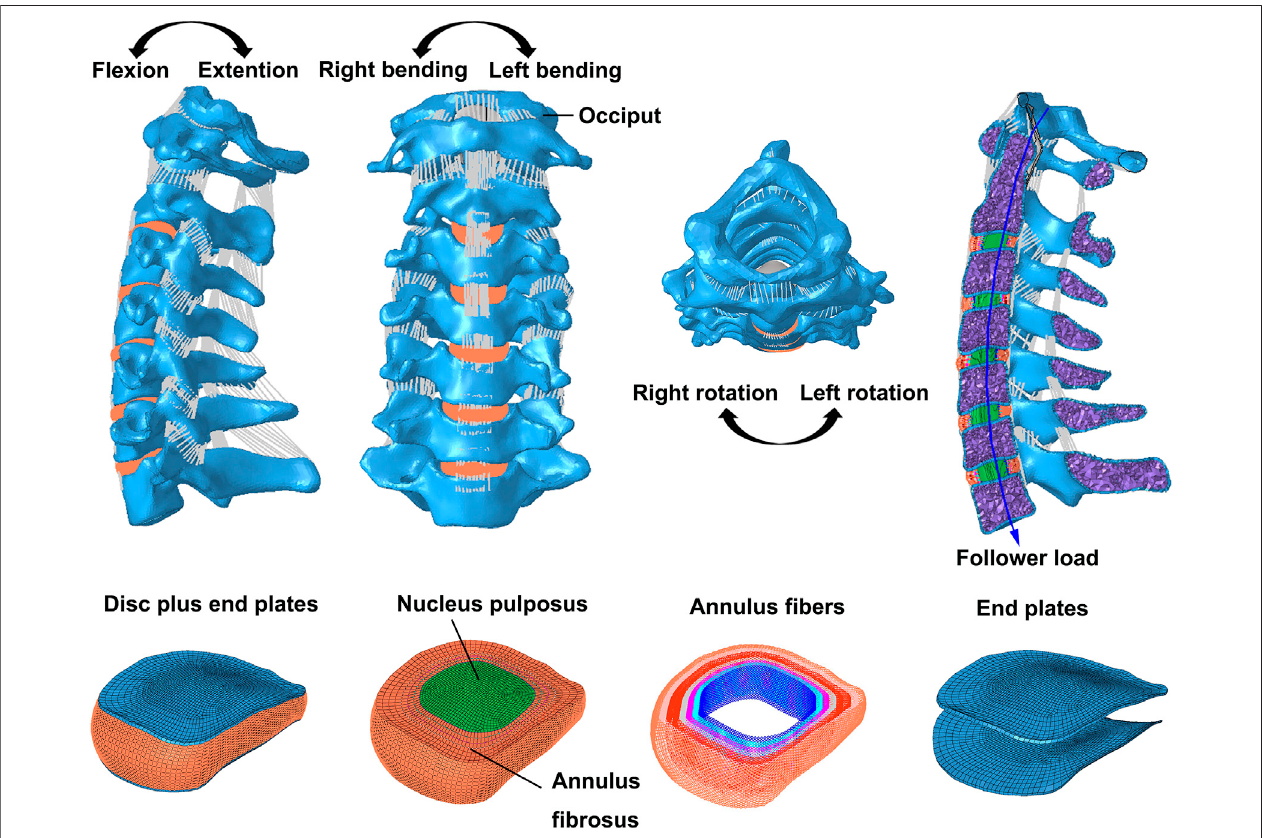
FIGURE1| ImagesoftheC0 – C7intactFEmodelimposedwithdifferentdirectionmomentand73.6 Nfollowerload,andthedecompositionviewsofintervertebral disc plus endplates were listed.